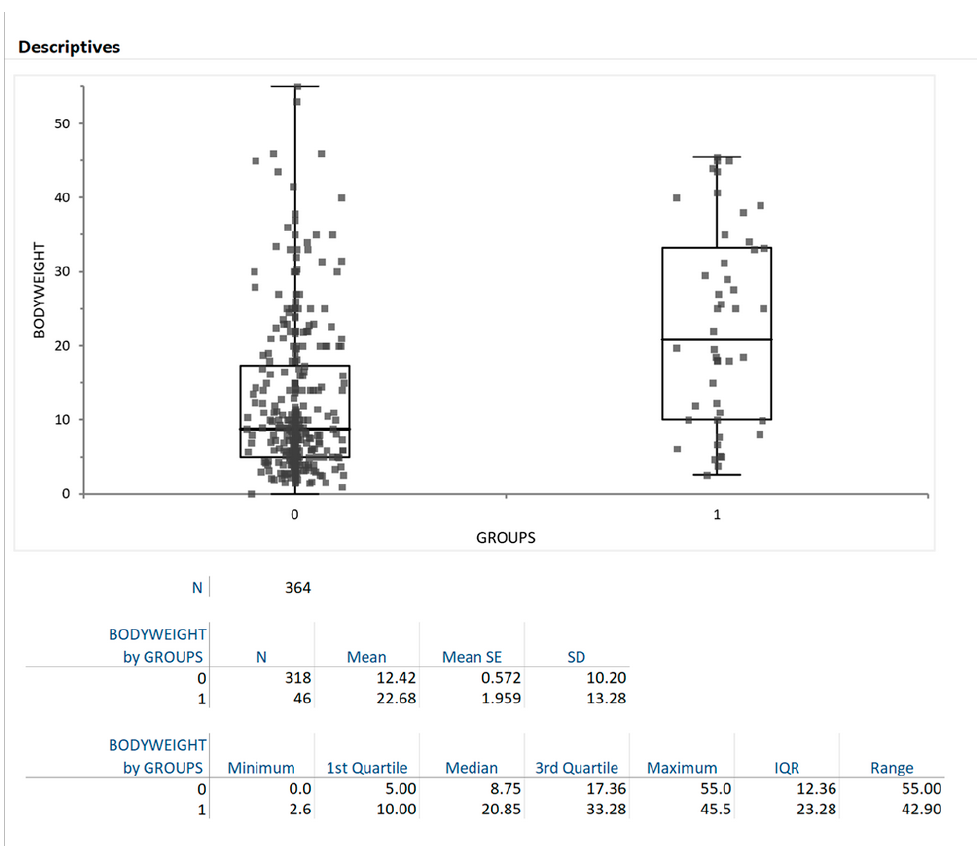
Figure 2. Box plot graph showing the age distribution in group 0 (control group) and affected group (group 1).